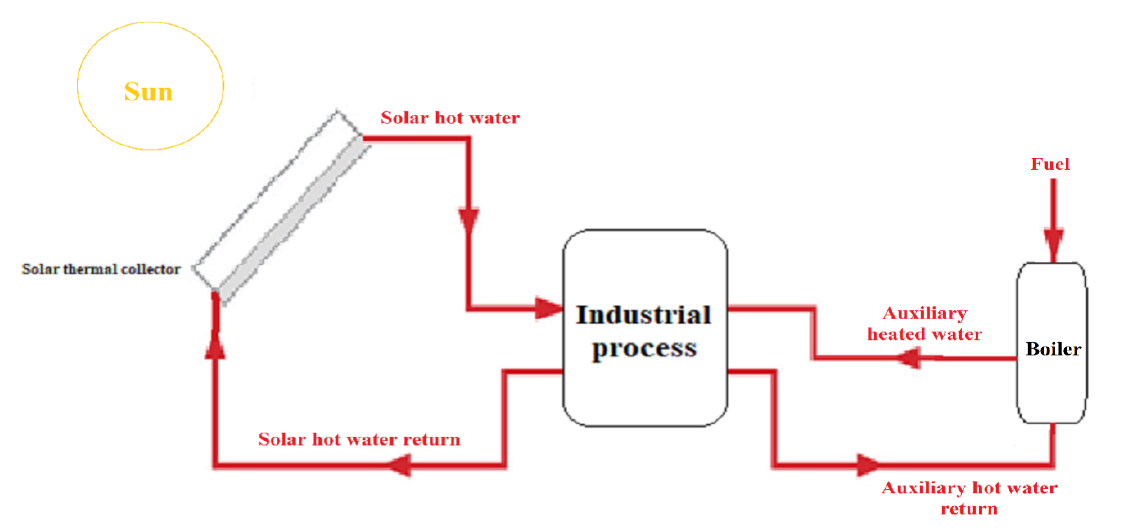
Figure 12. Integration of solar thermal energy to industrial processes.